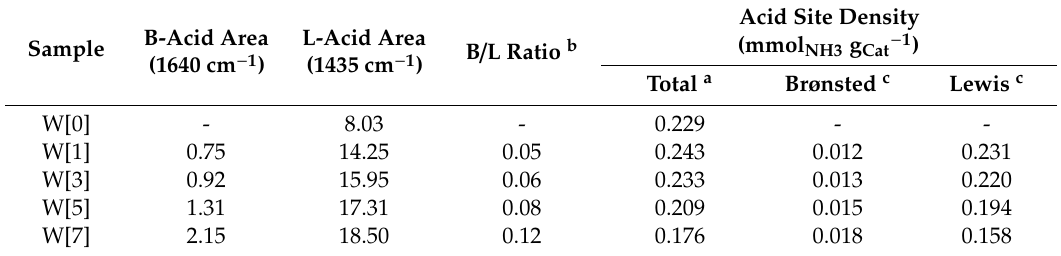
Table 5. Area and area ratio (B / L ratio) of Brønsted and Lewis acid sites on Pt–W[x] / TiO 2